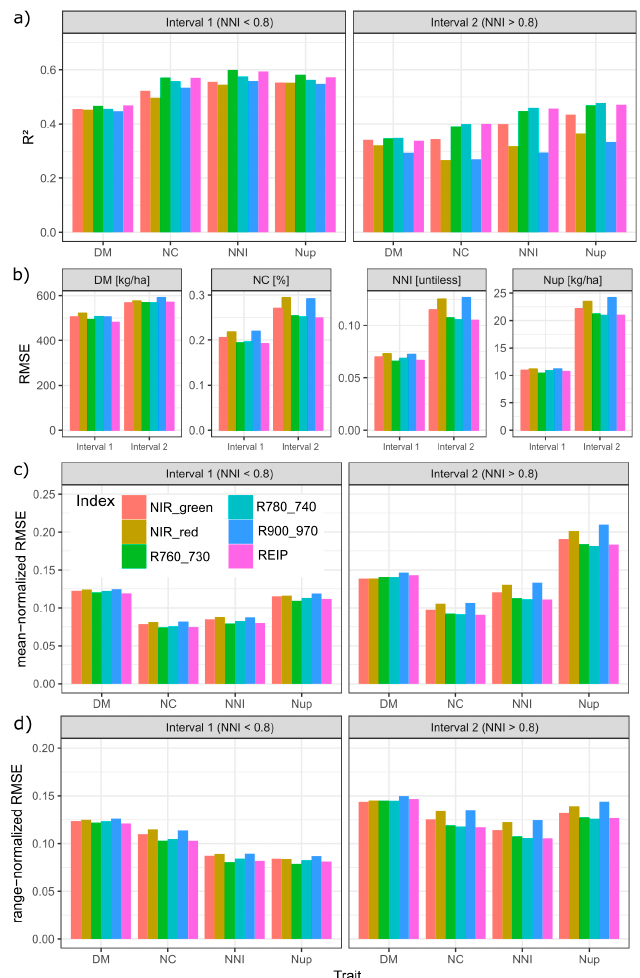
Figure 6. Index comparison by NNI-based intervals (interval 1: NNI < 0.8; interval 2: NNI > 0.8): (a) Coefficients of determination (R 2 ), (b) absolute root mean squared error (RMSE), (c) mean-normalized RMSE, and (d) range-normalized RMSE: Averaged across results of regressions within measurement date*main plot combinations (n = 18). See Supplementary Figure S5 and Supplementary Figure S6 for original results within date*main plot combinations.